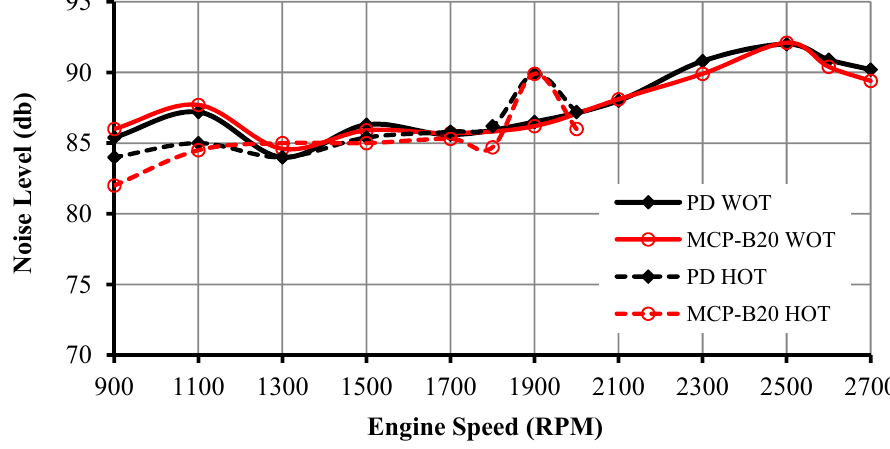
Figure 9. The relationship between tractor engine speeds (RPM) and noise level (db) for PD and